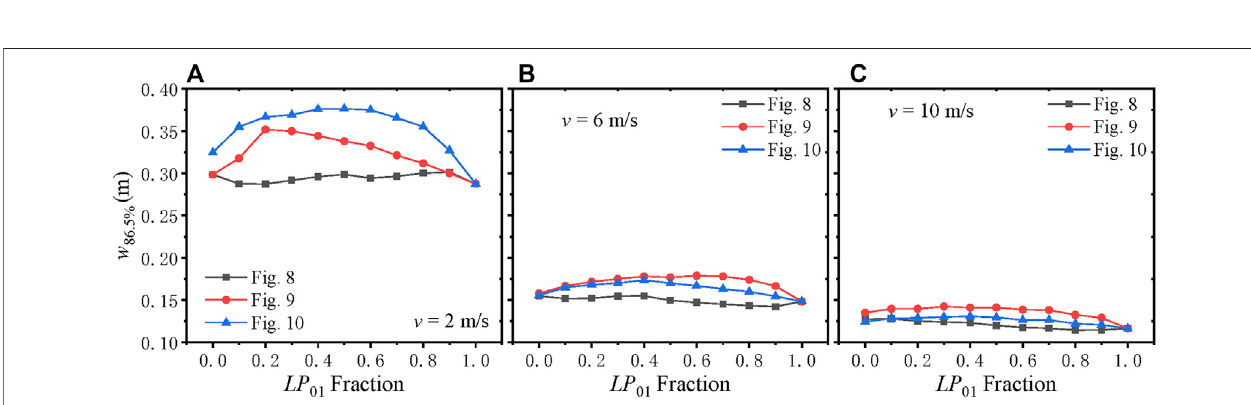
Frontiers in Physics |